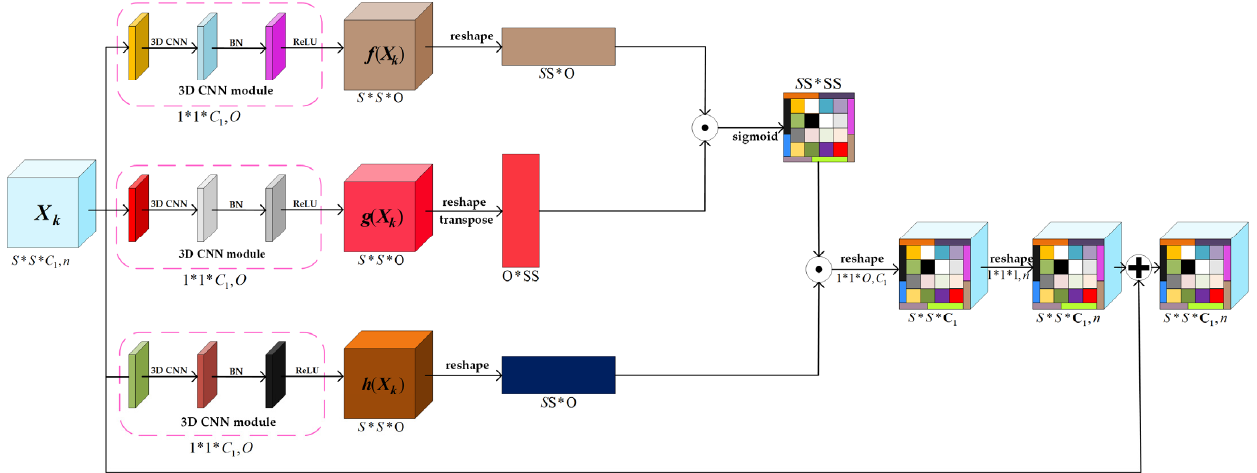
Figure 5. The structure of spatial attention module.